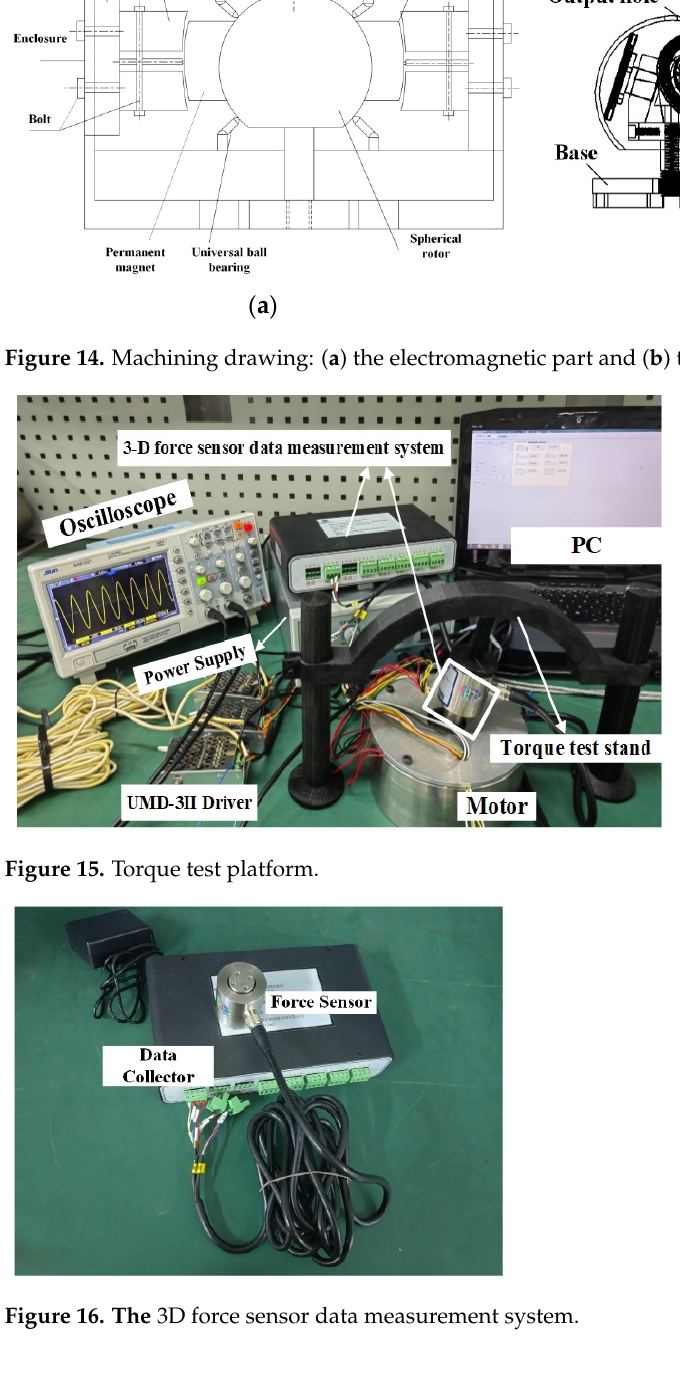
Figure 14. Machining drawing: ( a ) the electromagnetic part and ( b ) the piezoelectric part.